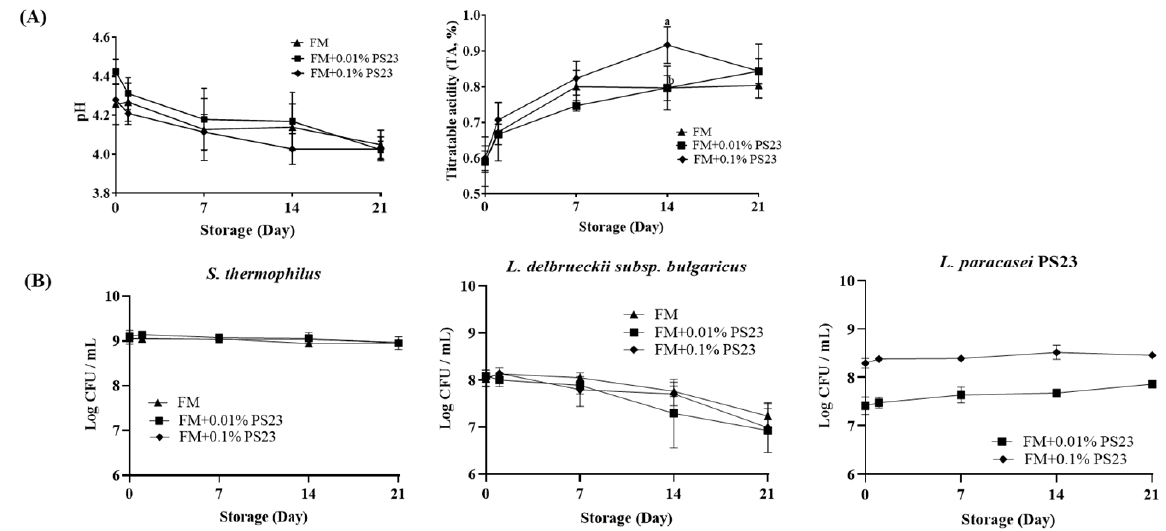
Figure 2. Effect of coculturing PS23 with yogurt culture ( Lactobacillus delbrueckii subsp. bulgaricus and Streptococcus thermophilus ) on ( A ) acidification and ( B ) bacterial counts of the fermented milk during 21-day storage. Data are expressed as mean ± SD. Experiments were performed in three independent replicates. Statistical analysis was performed using analysis of variance with the Tukey test. Different letters indicate a significant difference p < 0.05. PS23: Lactobacillus paracasei PS23, FM: fermented milk with yogurt culture. SD: standard deviation.